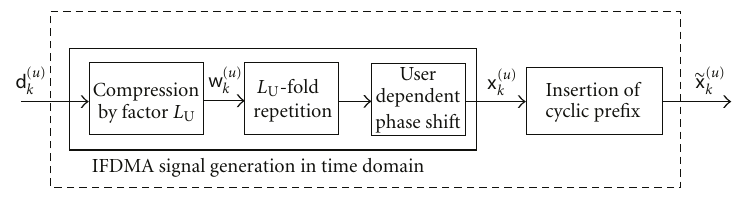
Figure 2: Block diagram of IFDMA signal generation in time domain and cyclic prefix